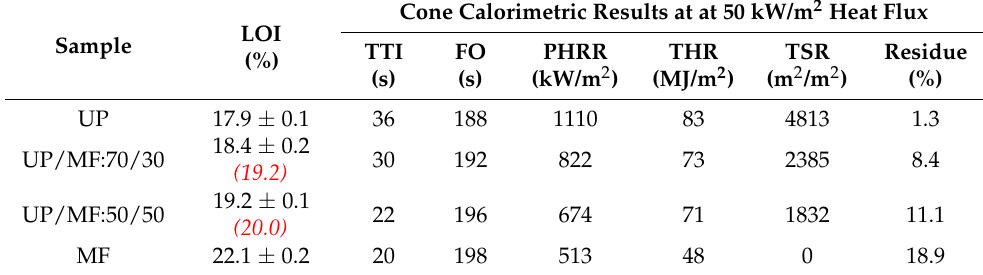
Table 6. Flammability results for cast resin samples of UP, MF, and UP/MF blends.